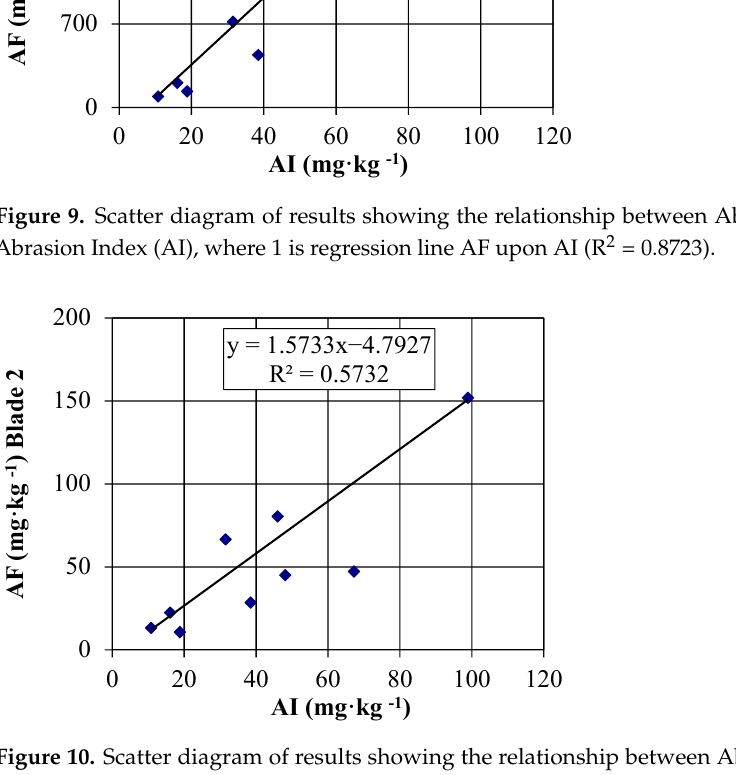
Figure 10. Scatter diagram of results showing the relationship between Abrasion Factor (AF) and Abrasion Index (AI), where 1 is regression line AF upon AI (R 2 = 0.5732).